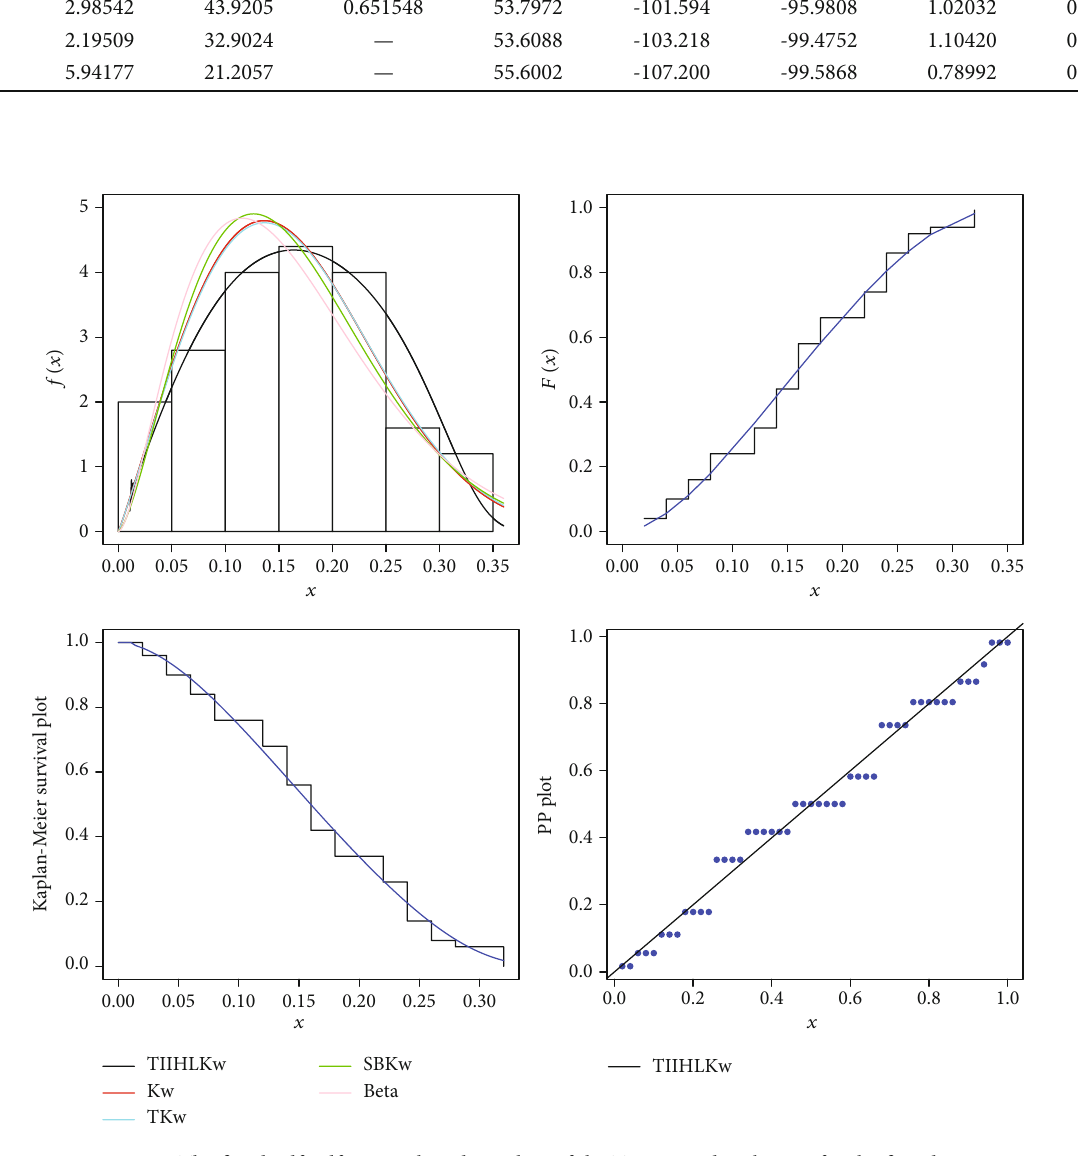
Figure 7: The fi tted pdf, cdf, survival, and PP plots of the TIIHLKw distribution for the fi rst data.